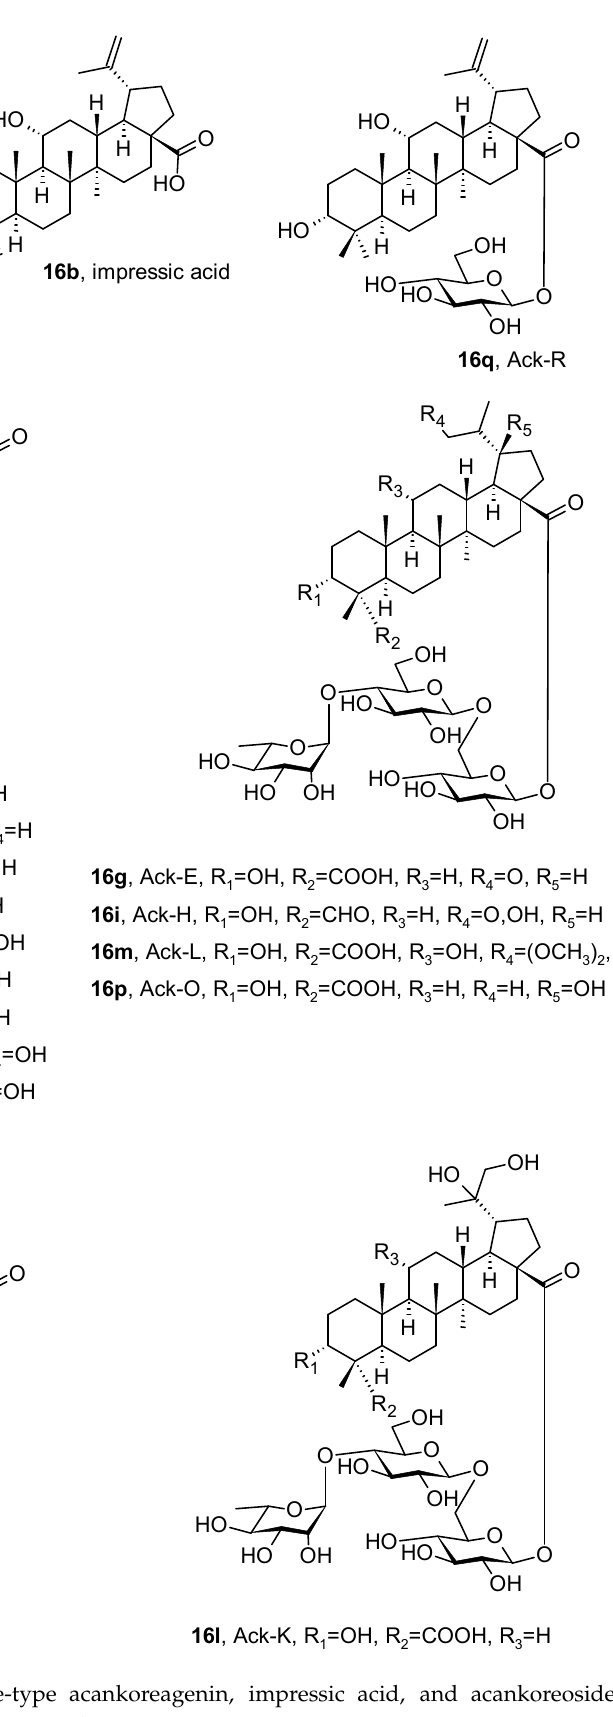
Figure 16. Lupane-type acankoreagenin, impressic acid, and acankoreosides from various Acan- thopanax ( Eleutherococcus ) species.